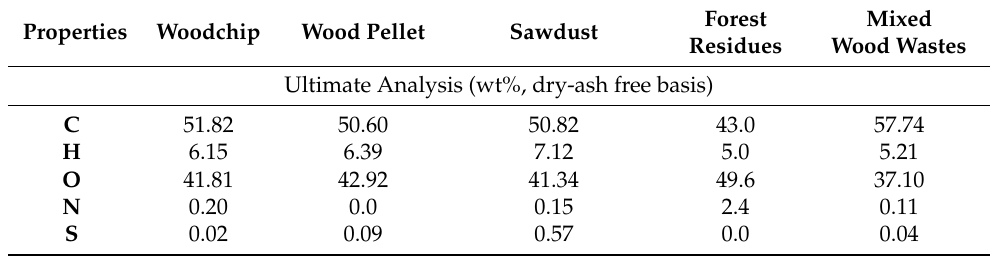
Table 2. Chemical composition of some woody